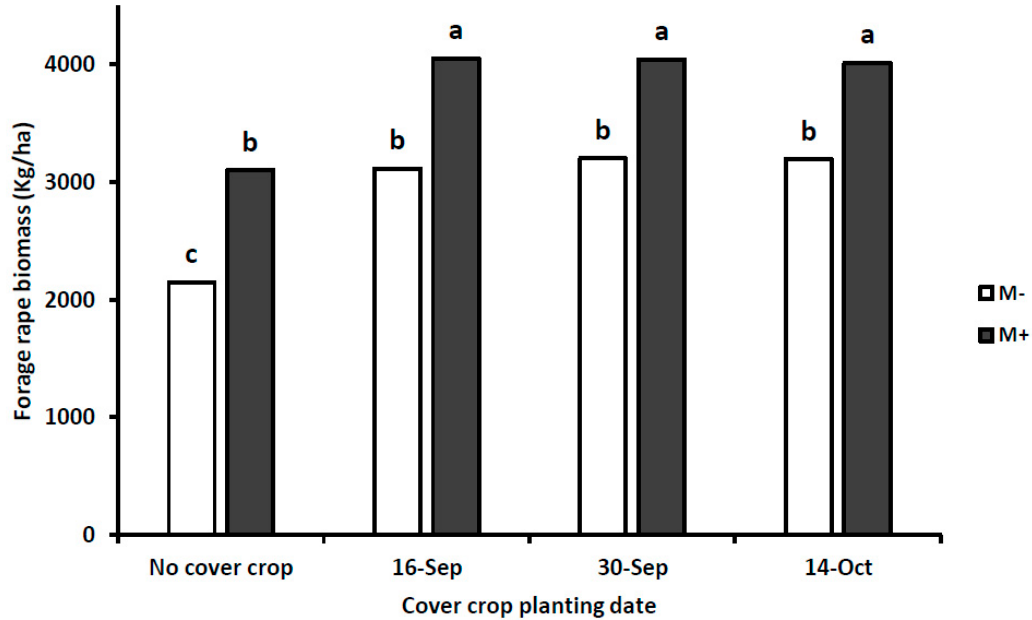
Figure 5. Forage rape yield as a function of cover crop planting date and manure application. Letters indicate mean separation by Duncan’s New Multiple Range Test ( p = 0.05). Rye cover crop added manure (M+) and Rye cover crop with no manure (M-)